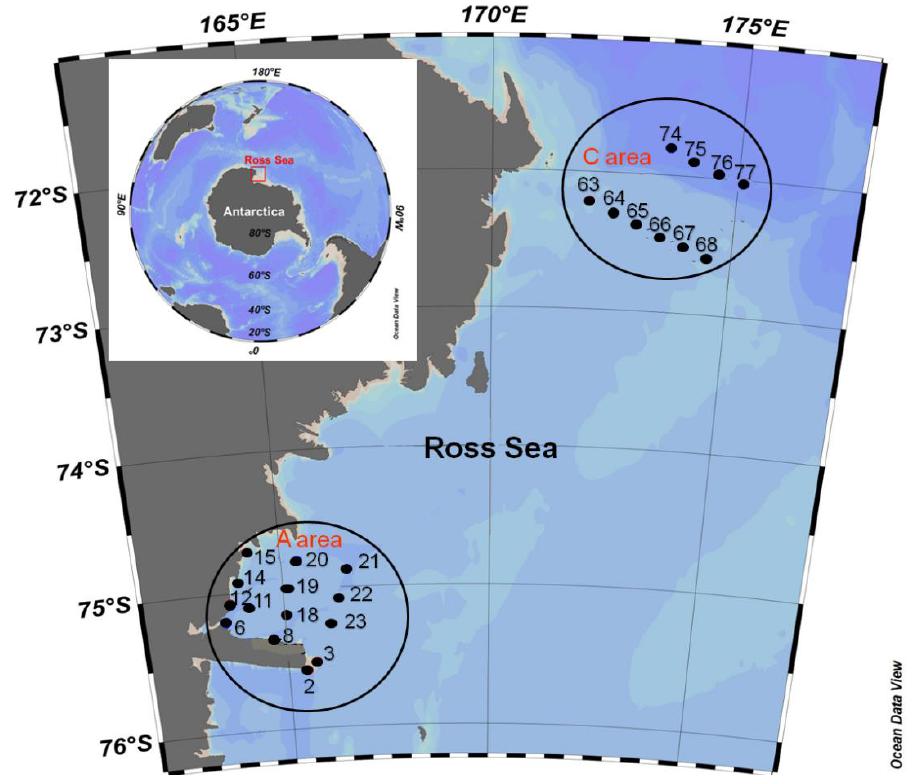
Figure 1. Location of the sampling stations: (A area) Drygalski glacier and Terra Nova Bay polynya; (C area) Cape Adare shelf break area.